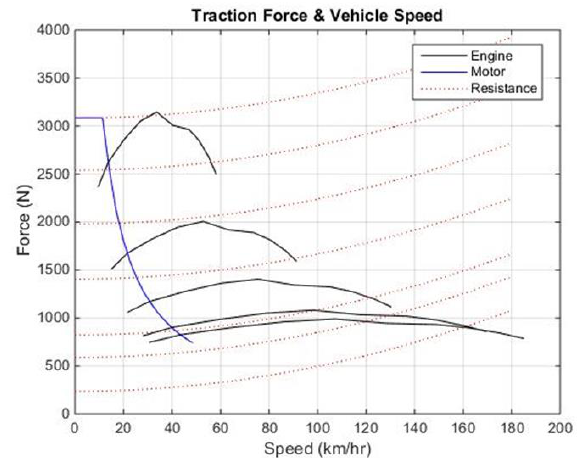
Figure 6. Traction force diagram with designed gear ratio.